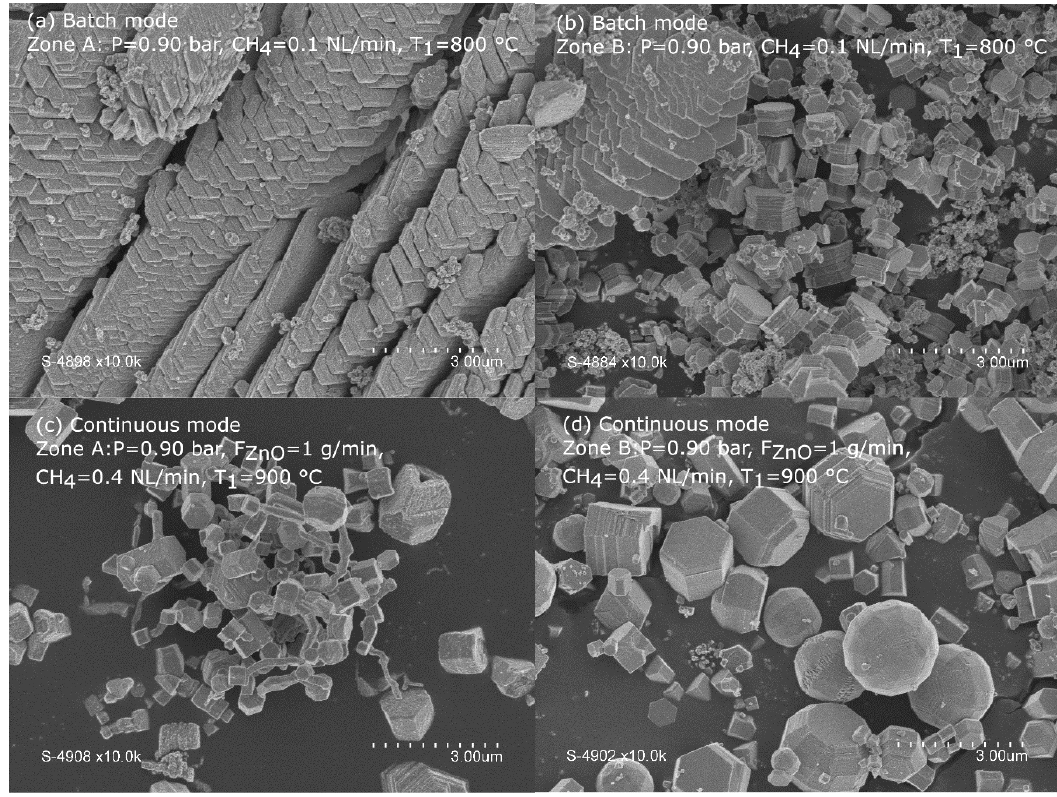
Figure 10. FESEM micrograph of ( a , c ) solid products in the outlet tube and connector (zone A), and ( b , d ) solid products in the ceramic filter (zone B). Source: author.